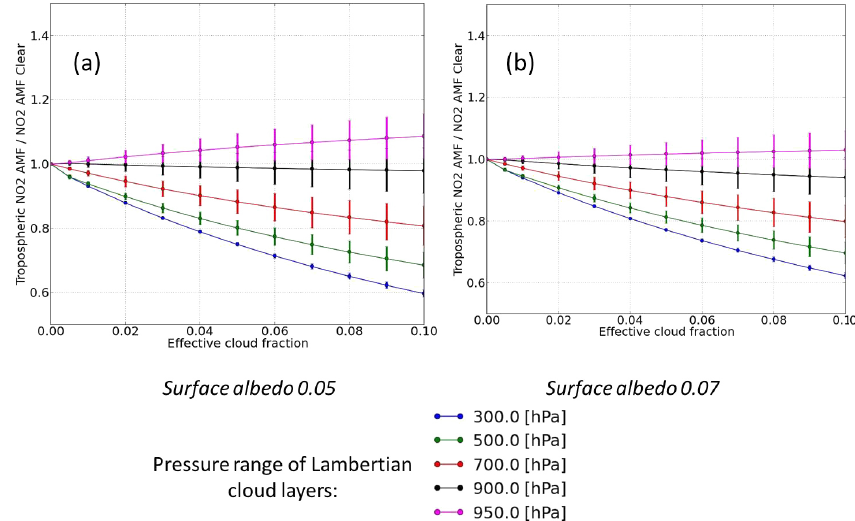
Figure 14. Tropospheric NO 2 AMF factor f at 439nm (see Eq. 5) based on OMI effective cloud parameters (i.e. effective cloud fraction and pressure) and for two surface albedos, derived from all the NO 2 vertical profiles from TM5 simulations, 2006, East China, July (see Fig. 1). Solid lines are the average, while error bars are the standard deviation, of f computed for all the individual TM5 NO 2 profiles over this period and this region: (a) surface albedo 0.05, (b) surface albedo